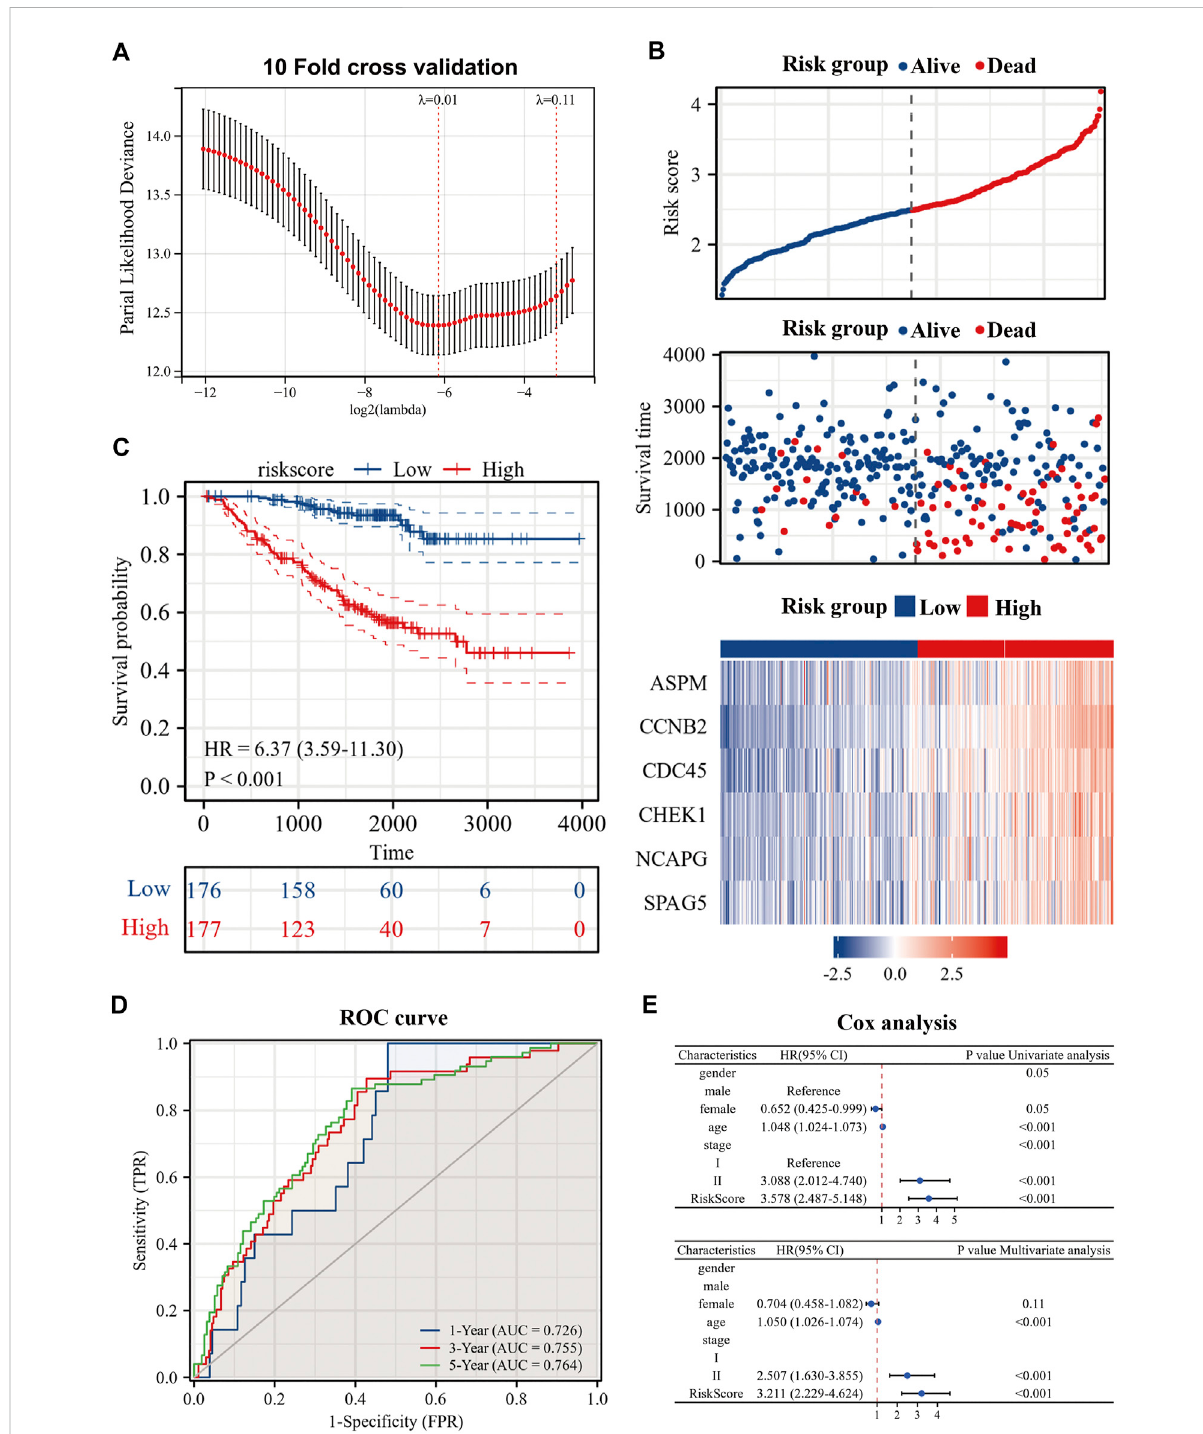
FIGURE 4 Construction of risk model by six genes. (A) Construction of prognostic signature by Lasso regression and 10-fold cross validation; (B) Risk factor diagram of es-LUAD patients; (C) KM prognostic curve of training group; (D) ROC curve of training group; (E) Univariate Cox analysis and Multivariate Cox analysis of risk score. Lasso: Least absolute shrinkage and selection operator; KM: Kaplan-Meier; ROC: receiver operating